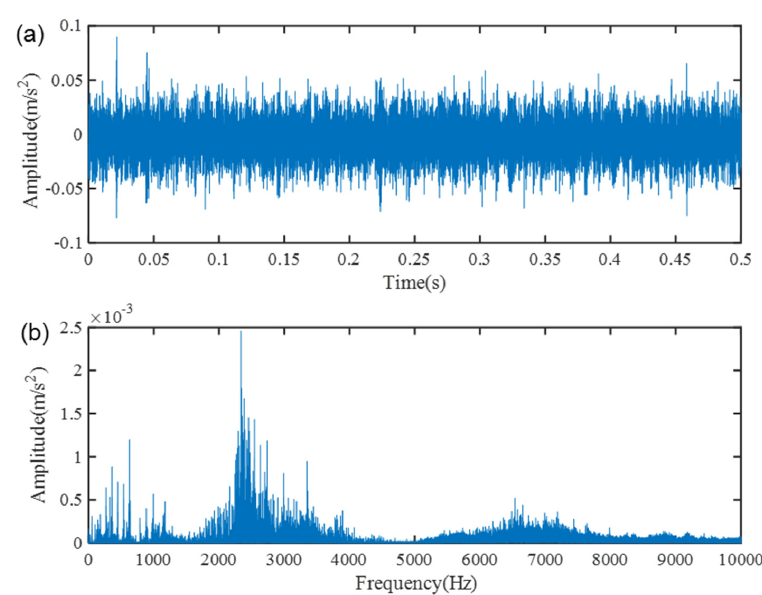
Figure 10. The motor vibration signal: ( a ) waveform; ( b ) spectrum.